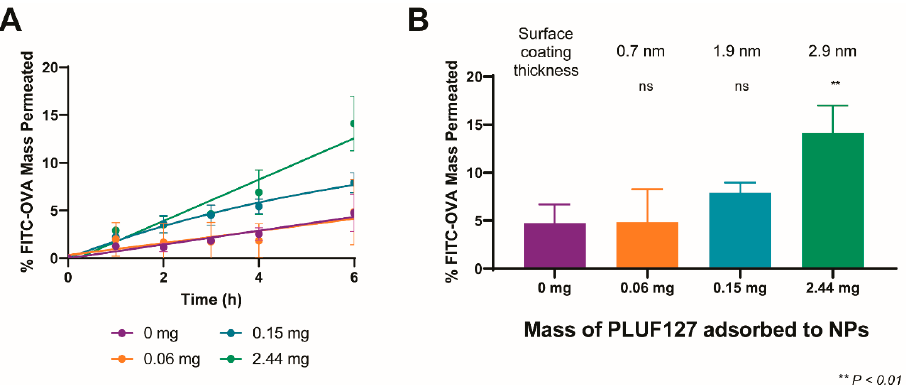
Figure 6. Mucus diffusion of PLGA nanoparticles with increasing degree of PEGylation in BSM ( A ). Comparative permeation of all formulations at 6 h ( B ). Statistics indicate significance compared to uncoated PLGA-NP( − ). Non-significant data is designated ‘ns’.